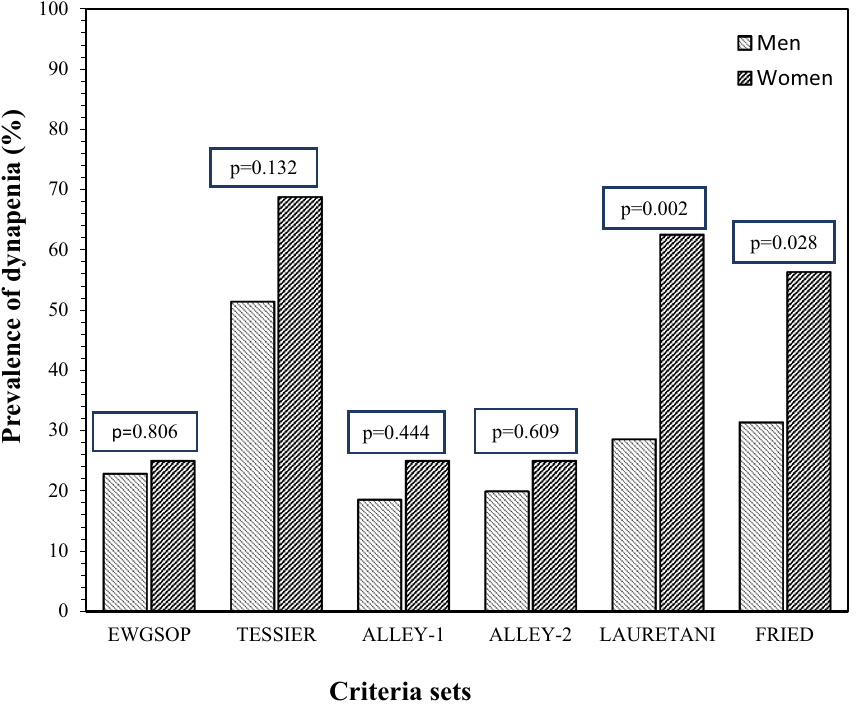
Figure 1. Prevalence of dynapenia (according to different criteria sets) by gender in the 102 patients with idiopathic pulmonary fibrosis (IPF) participating in the study.